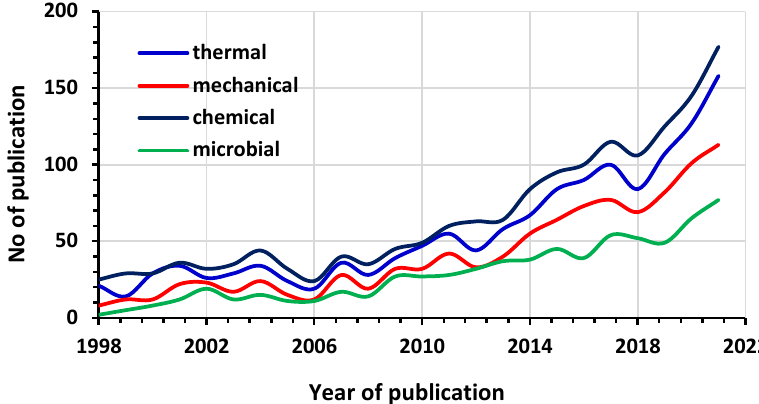
Figure 1. Technologies for inhibition and removal of wax deposition.